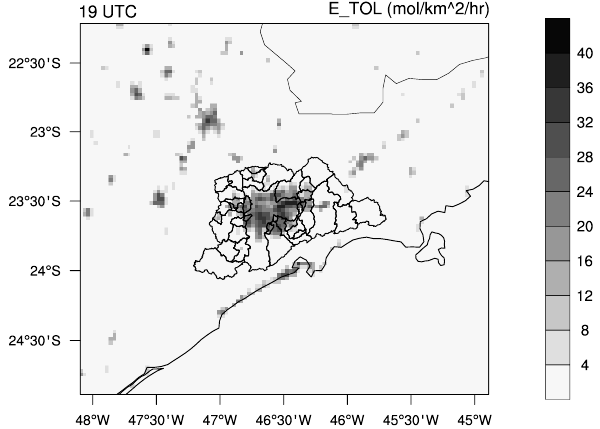
Figure 2. Emission rates for Aromatic VOCs at 19:00UTC in the 3km modelling